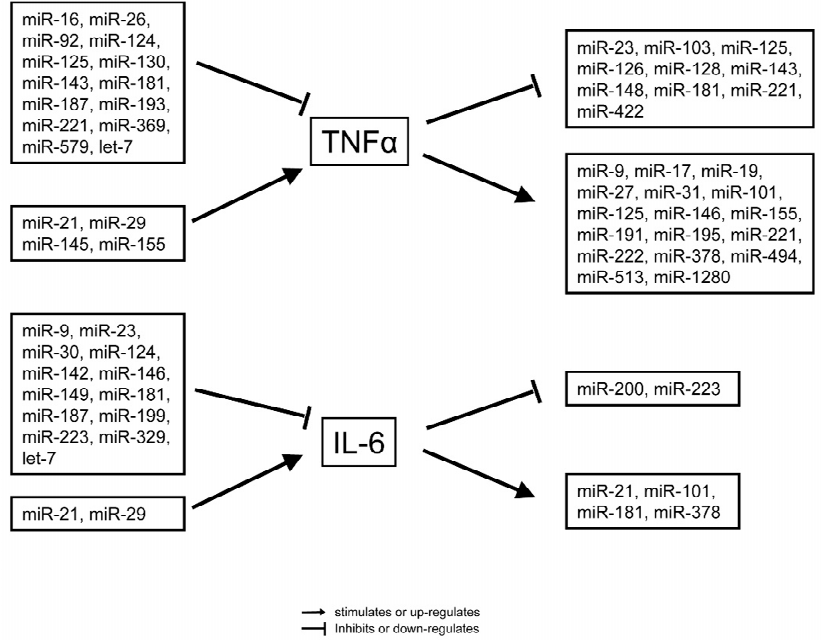
Figure 3. Modulation of the pro-inflammatory cytokines TNF- α and IL-6 by various miRNAs and vice versa .